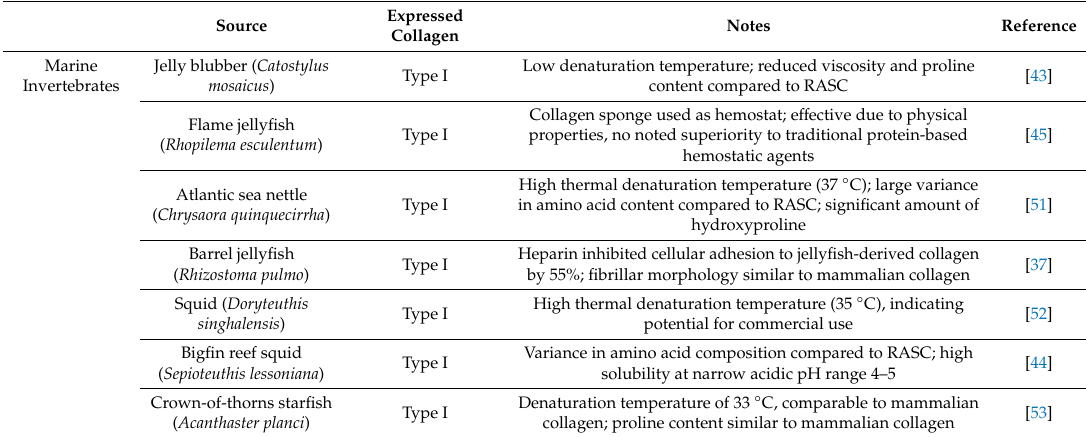
Summary of marine-derived collagen isolates, with notes indicating variation from mammalian-derived collagen and potential